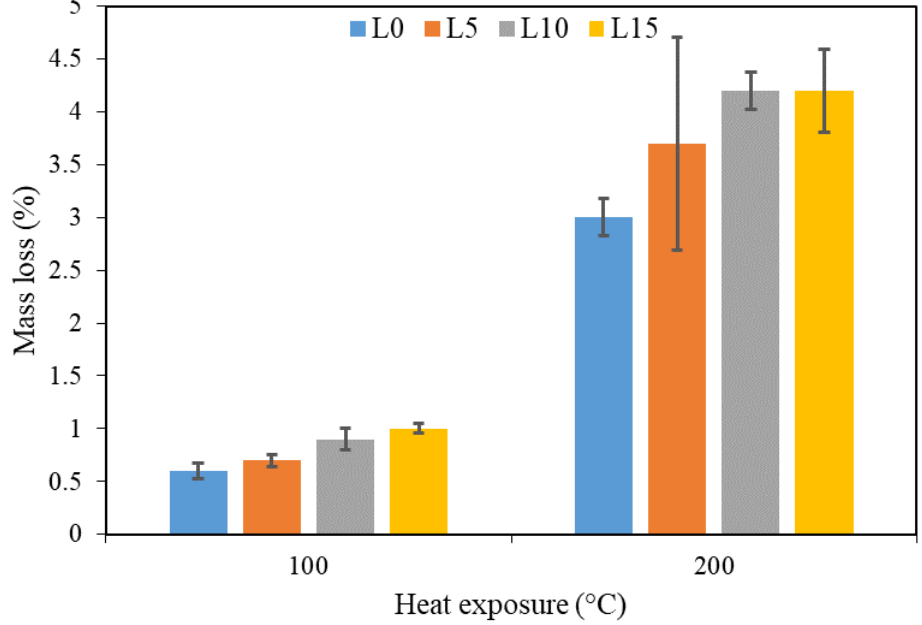
Figure 3. Percentage of mass loss after heat exposure.